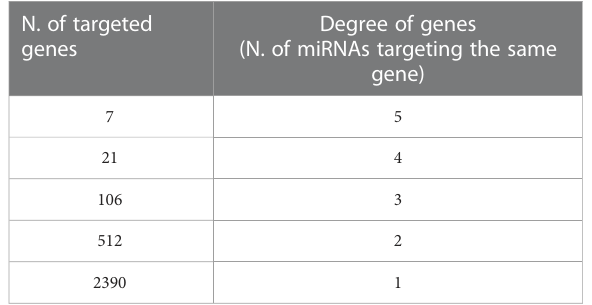
TABLE 4 Degree of putative target genes in the miRNA-target interaction network. N. of targeted